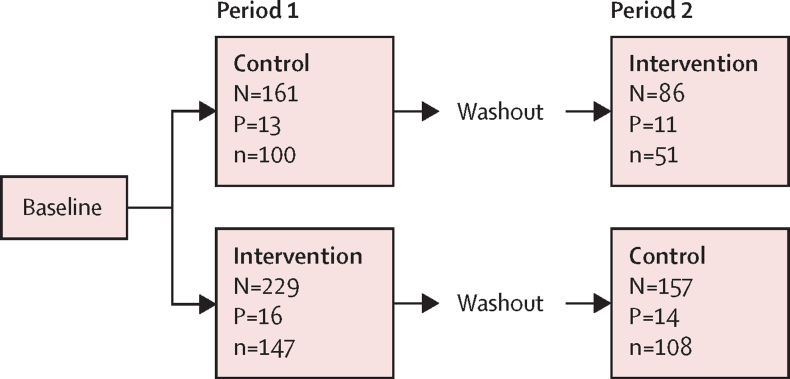
Flowchart of participantsN is the number of women recruited, P is the number of pharmacies, and n is the number of women providing follow-up at 4 months.